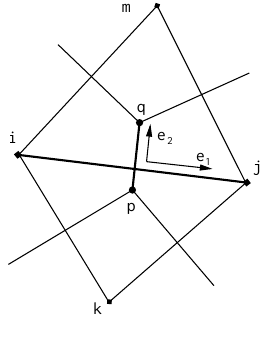
Figure 1. Two-dimensional case.